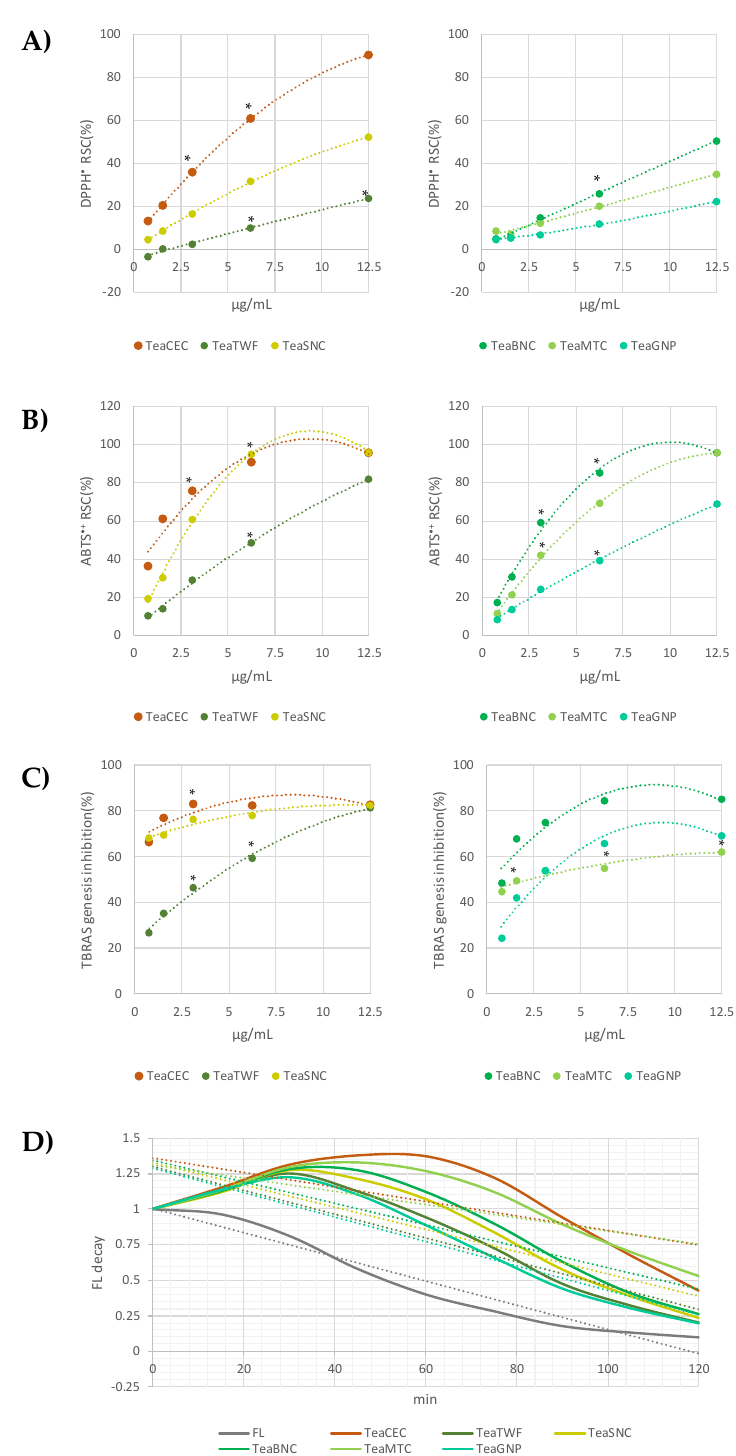
Figure 7. Radical Scavenging Capacity (RSC, %) of green tea extracts vs. 2,2 (cid:48) -diphenyl-1-picrylhydrazyl) (DPPH) radical ( A ) and 2,2’-azino-bis(3-ethylbenzothiazoline-6-sulfonic acid (ABTS) radical cation ( B ). Inhibition of thiobarbituric acid reactive substances (TBARS) species formation (%; C ). Values are the mean ± SD of two independent experiments performed in triplicate. * p < 0.05 vs. blank. ( D ) Fluorescein fluorescence decay induced by the 2,2 (cid:48) -azobis-(2-amidinopropane)-dihydrochloride (AAPH) radical generator. The decay is strongly delayed by the co-presence of the extracts already at 0.78 µ g / mL